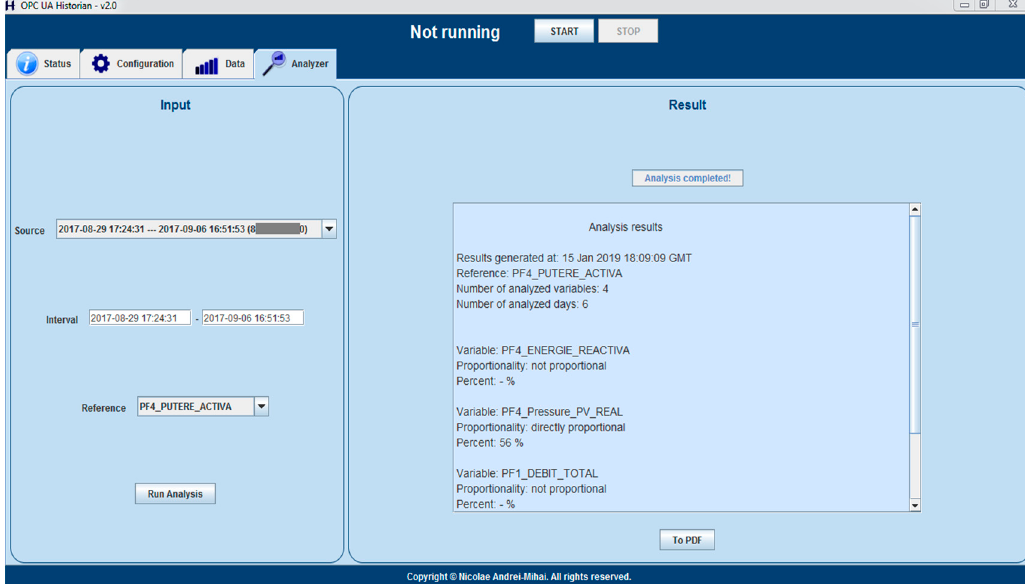
Figure 5. Integration of the proposed algorithm into the Historian application GUI.